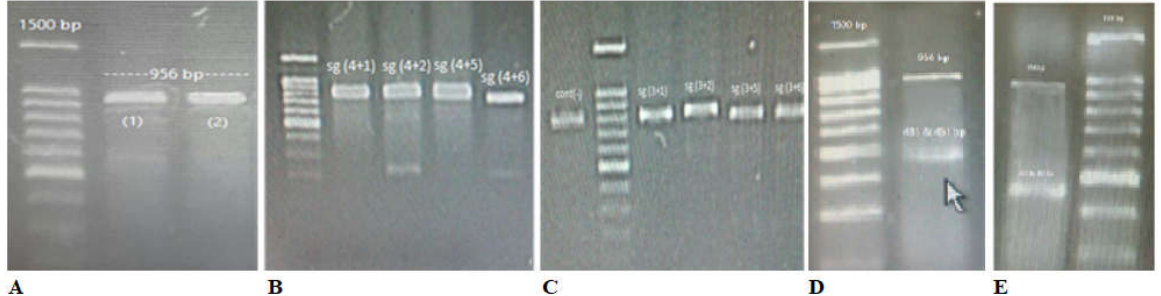
Fig. 3. Evaluation of gene cleavage: A) PBMCs transfection by vector backbone (Negative control); B and C) Lack of cleavage bands after transfecting HEK293 cells by lipofectamine and electroporation methods; D) & E) PD-1 knockout by sg (3+1) and sg (3+5) through lipofectamine and electroporation methods; 1500bp= DNA Size Marker, 100 bp Ladders (100-1,500 bp), BioAcademia Co.